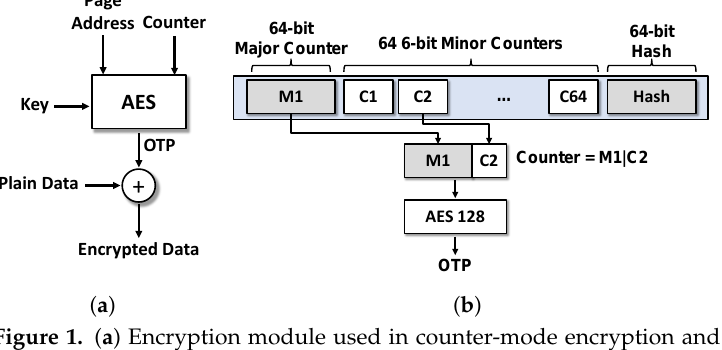
Figure 1. ( a ) Encryption module used in counter-mode encryption and ( b ) a tree node of a split counter